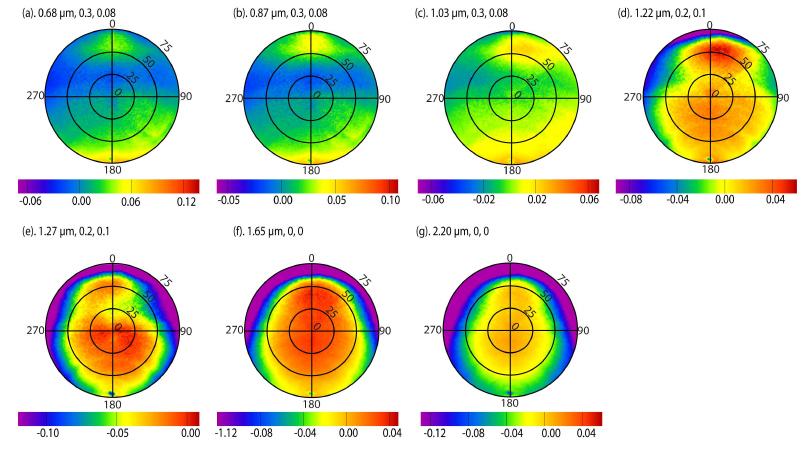
Fig. 10. Difference between derived CAR BRF and modeled BRF (RNew) in seven CAR bands for flight 2001b. Three numbers above each image give the wavelength and parameters σ and D